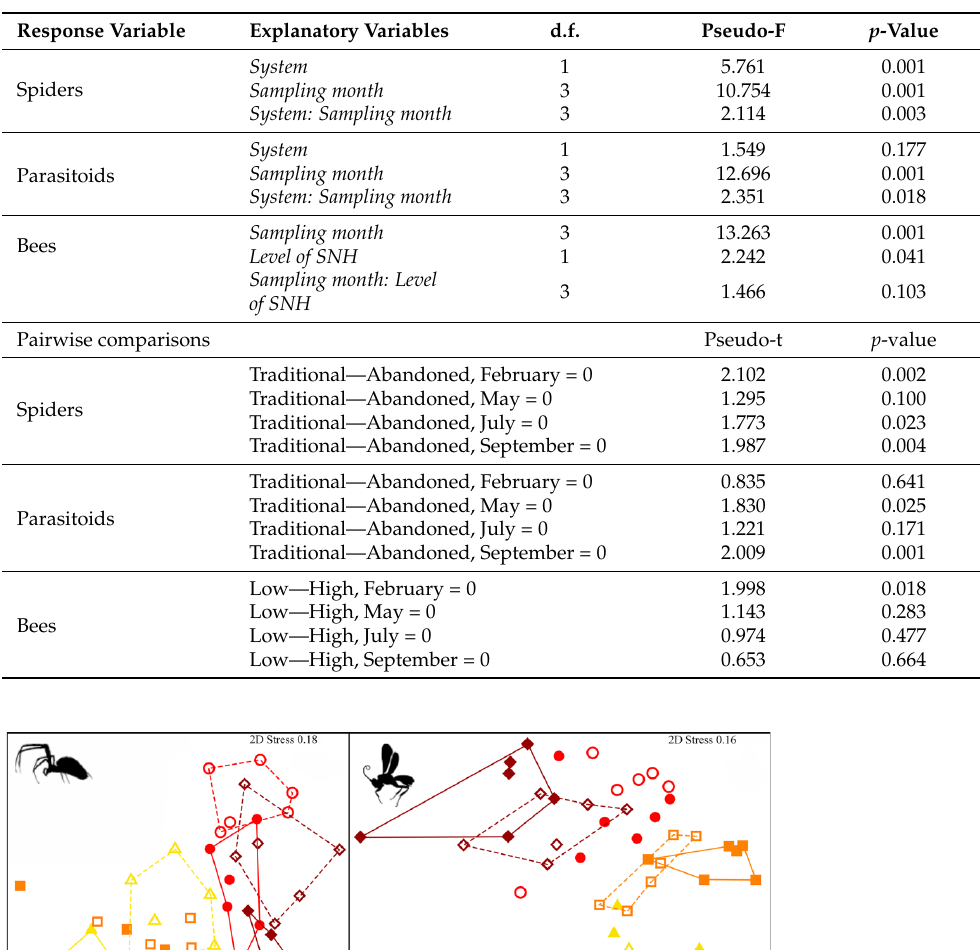
Table 1. Results of the PERMANOVA for the variables system (abandoned vs. traditional), sampling month , and level of semi-natural habitats (high vs. low) (full model results and pairwise comparisons). SNH = semi-natural habitats.